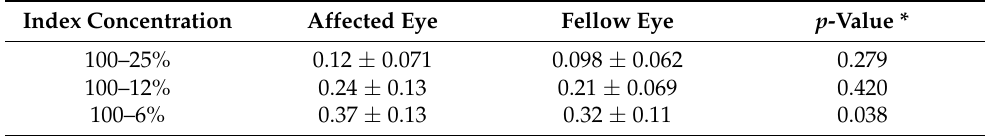
Table 3. Amount of changes in contrast visual acuities between affected and fellow eyes.